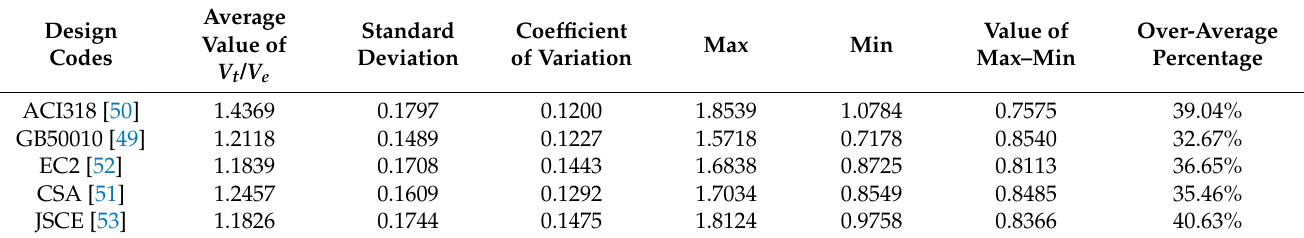
Figure 3. Punching shear resistance of different design codes: ( a ) ACI318; ( b ) GB50010; ( c ) EC2; ( d ) CSA; ( e ) JSCE. Table 3. Comparison of punching shear resistance between various design codes.